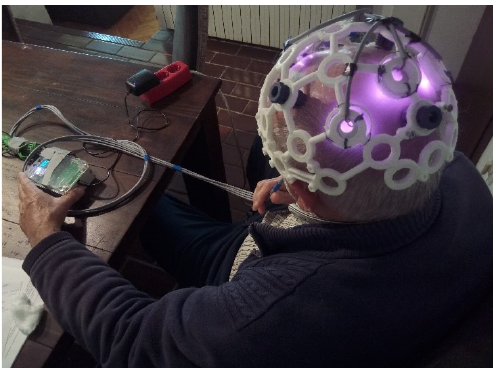
Figure 5. Schematic representation of the study